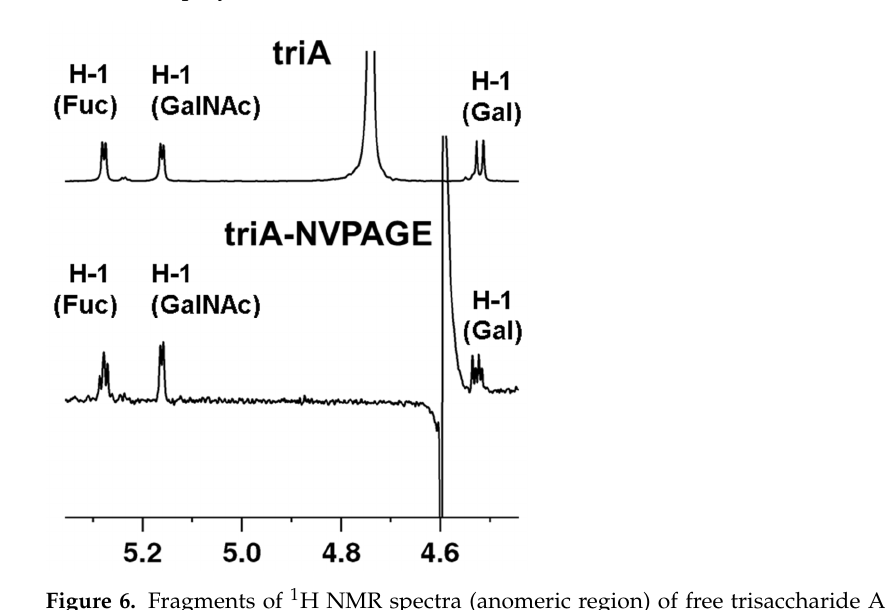
Figure 6. Fragments of 1 H NMR spectra (anomeric region) of free trisaccharide A and polymer- based conjugate.